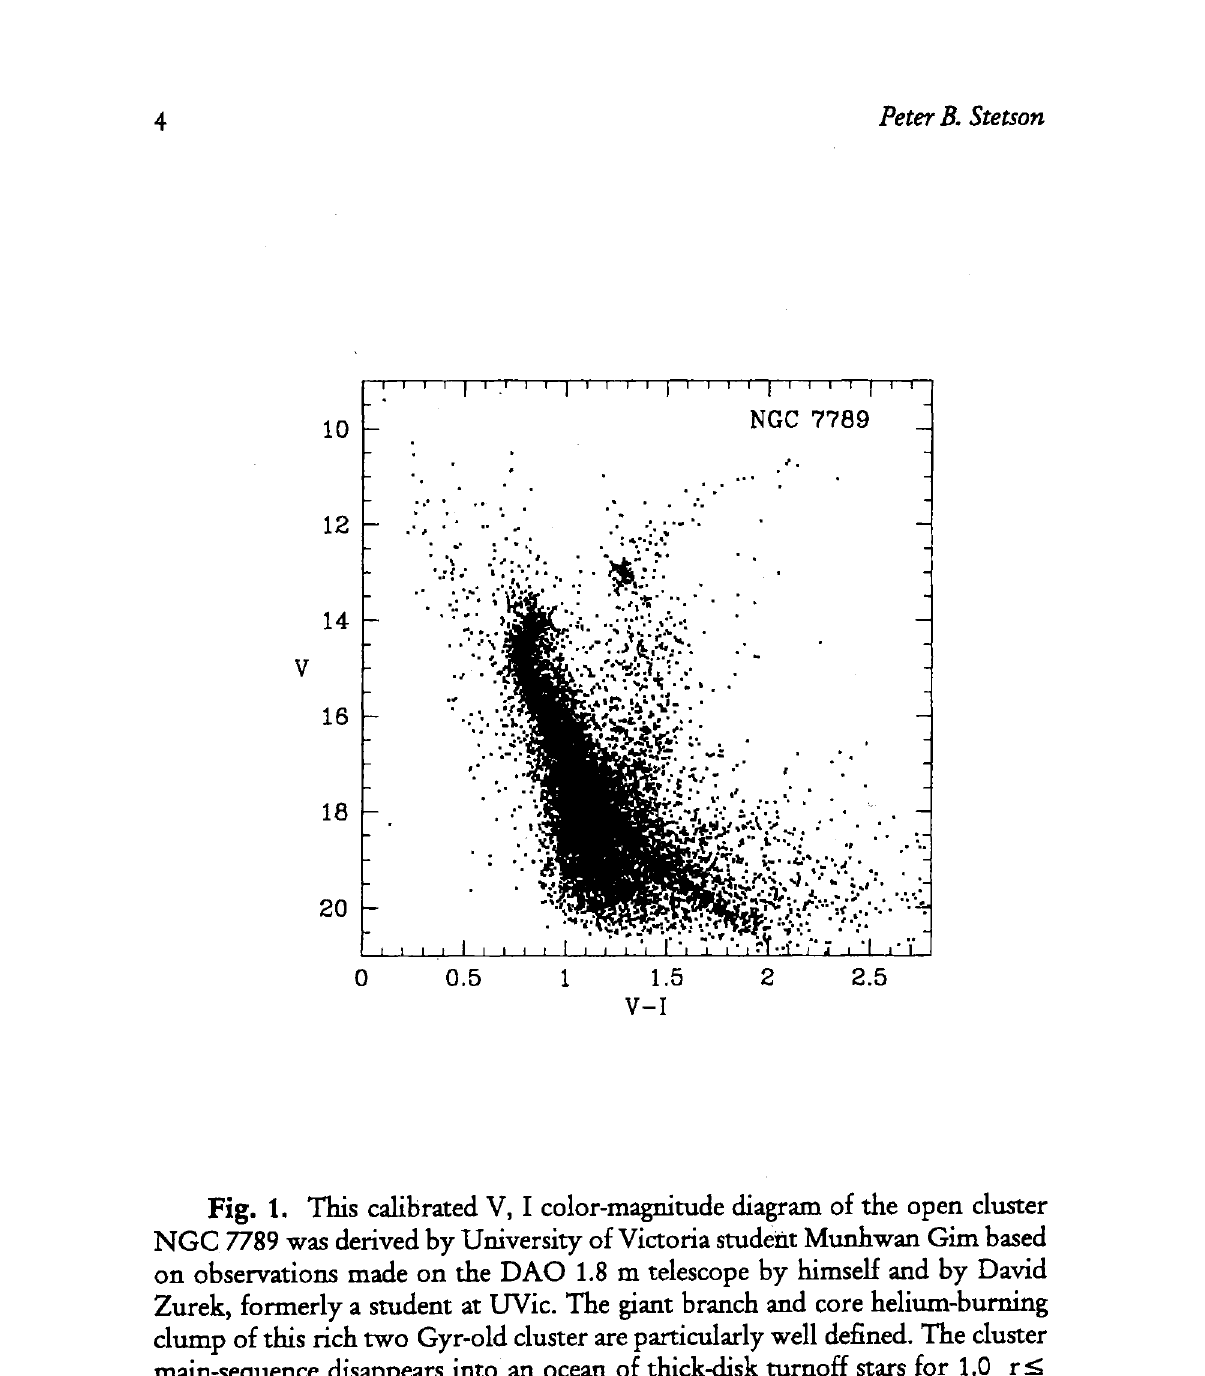
Fig. 1. This calibrated V, I color-magnitude diagram of the open cluster NGC 7789 was derived by University of Victoria student Munhwan Gim based on observations made on the DAO 1.8 m telescope by himself and by David Zurek, formerly a student at UVic. The giant branch and core helium-burning clump of this rich two Gyr-old cluster are particularly well defined. The cluster main-sequence disappears into an ocean of thick-disk turnoff stars for 1.0 r ^ V —I <, 1.5, but may be perceived again near V « 20; we hope to obtain proper motions to establish membership